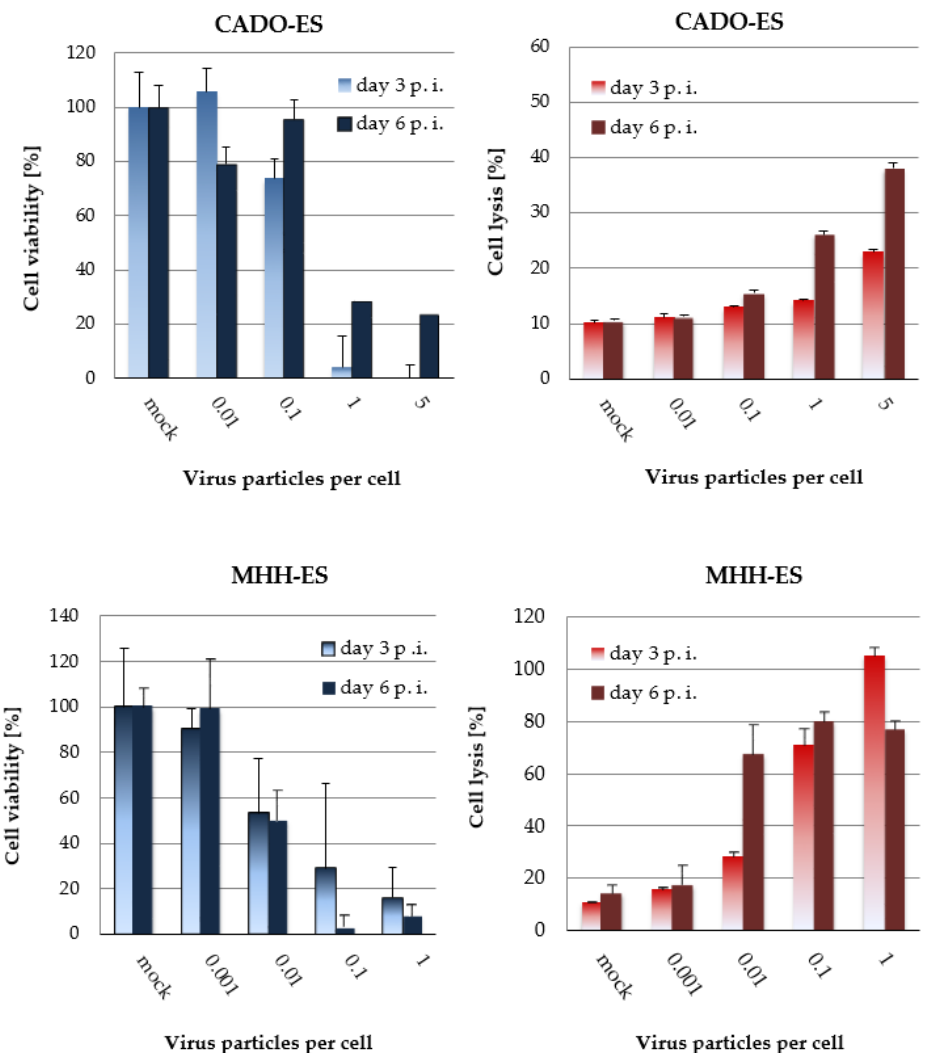
Figure 4. Ewing sarcoma cells undergo lytic infection by H-1PV. The viability of Ewing sarcoma cells was quantified in MTT tests three and six days after infection with wild-type H-1PV at the indicated MOI. Metabolic activity is expressed in relation to mock-treated control cells. Cell lysis due to H-1PV infection was quantified in LDH-release assays. Complete lysis of cells with a detergent-containing lysis buffer was used as a reference. Error bars indicate standard errors of the mean (SEM). These results are also summarized in Table 1. Table 1. Origin of the Ewing sarcoma (EWS) cell lines and ED50 of H-1PV as determined by cytotoxicity testing.